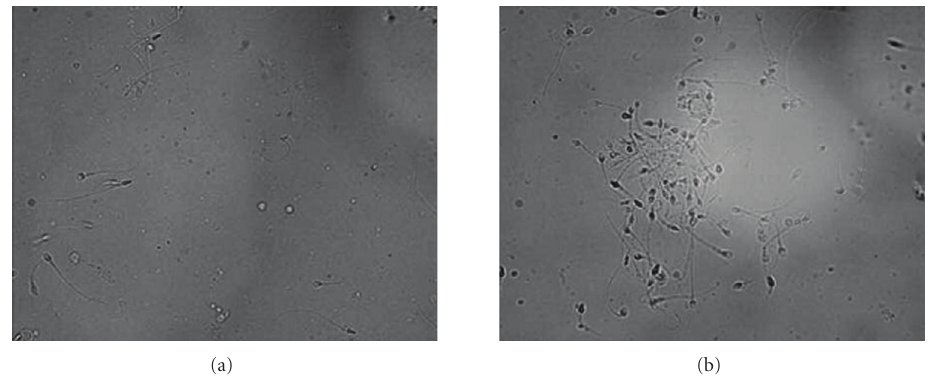
Figure 1: E ff ect of dermaseptin on sperm motility. Motile spermatozoa were preincubated in the presence or absence of increasing concentrations of five dermaseptins derivatives for 20 seconds photomicrographics (a) control and (b) in the presence of dermaseptin; complete sperm immobilization was seen after treatment (aggregate of spermatozoa at EC 100 = 25 μ g/mL)). Original magnification 100